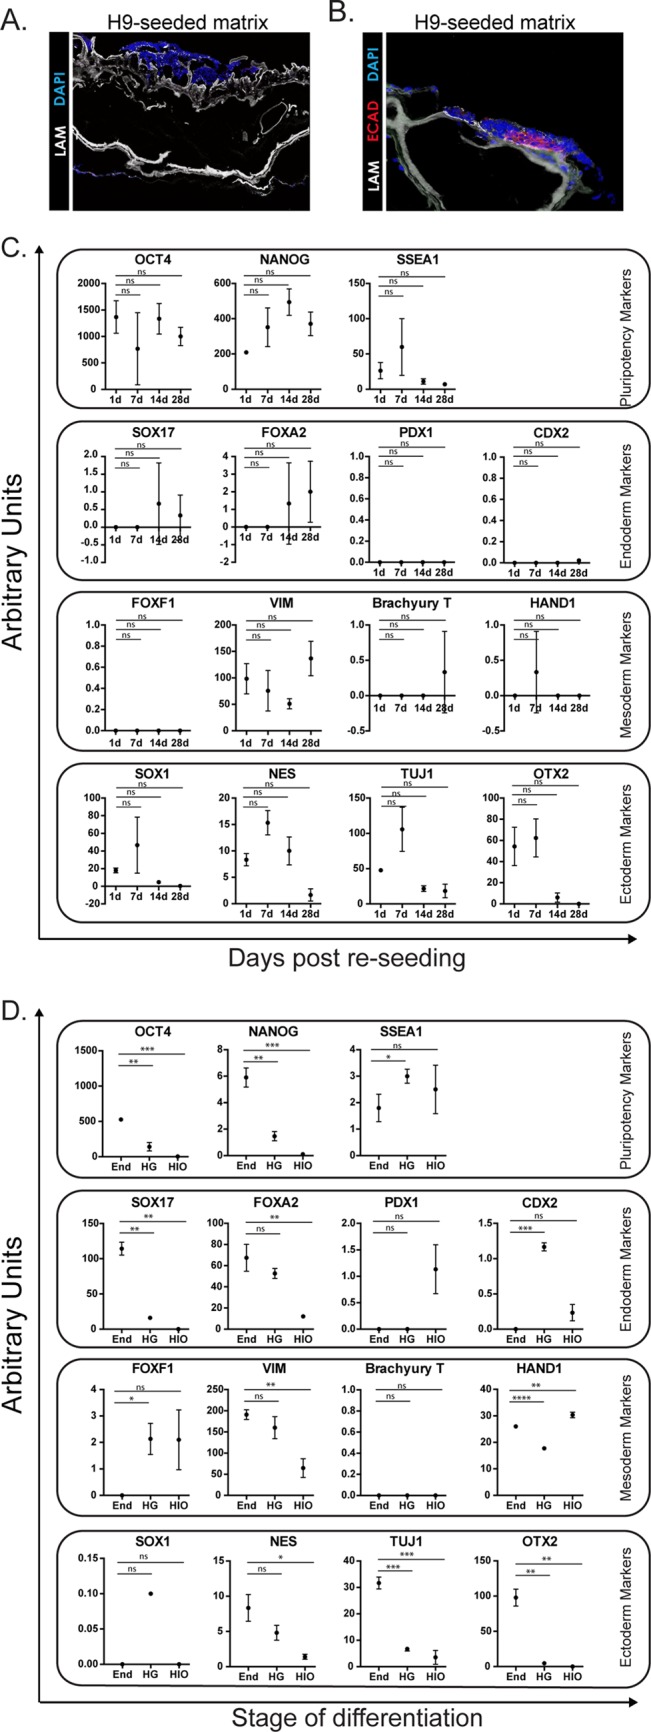
Acellular porcine matrices seeded with pluripotent stem cells. (A) H9 human pluripotent stem cells (hPSCs) are able to reseed acellular porcine matrix but do not penetrate into the matrix very well as examined after 4 weeks post seeding. (B) Some stem cells that were seeded onto the matrix expressed Ecad when analyzed 4 weeks post seeding suggesting that at least a portion of the hPSCs had begun to differentiate. (C) hPSC-seeded porcine matrices were analyzed by qRT-PCR at different time point to examine the expression of stem cell, endoderm, mesoderm, and ectoderm markers. From this analysis, it does not appear that porcine matrix drives hPSCs in any specific direction of differentiation. (D) Cells were examined at different stages during the development of HIOs to provide a reference for part C. As expected, pluripotency markers are low and endodermal markers go up during the development process. Note scale differences of the y-axes between C and D for some genes. N=3 for each sample type. *P<0.05 based on an unpaired t-test using Welch's correction, error bars represent s.e.m.